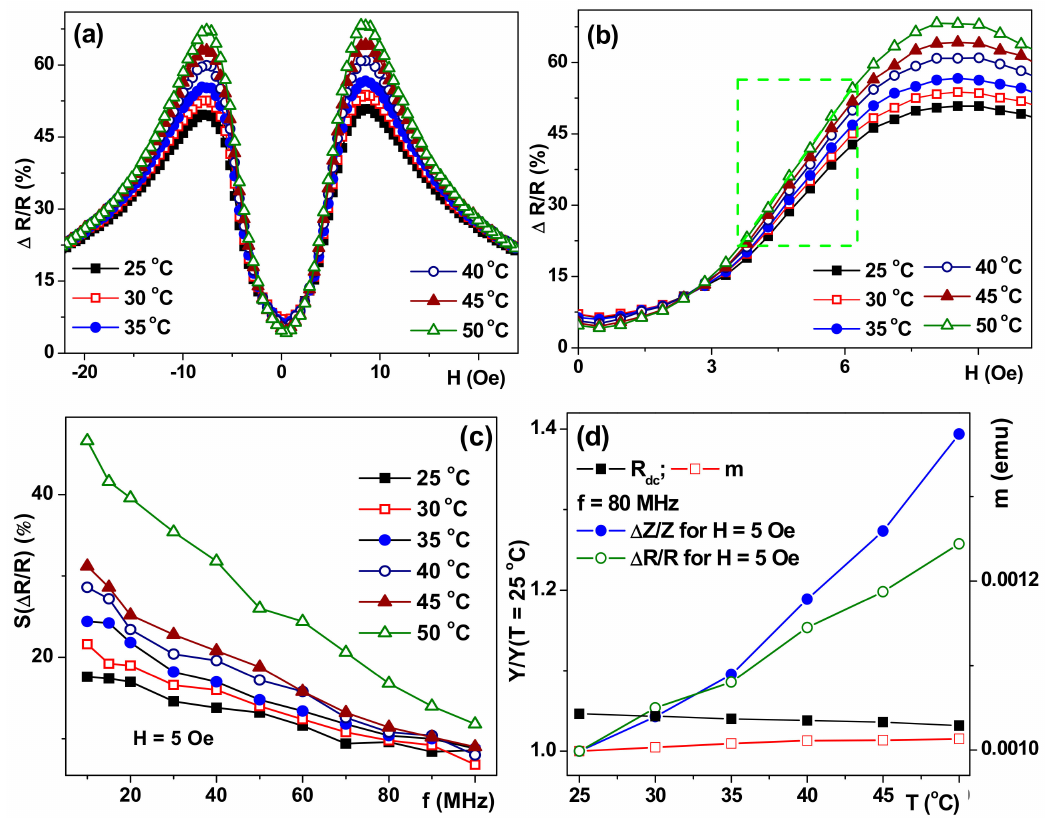
Figure 5. All data for sample S. Field dependencies of the GMI ratio for thereal part of the total impedance for at f = 80 MHz measured at different temperatures ( a ). A section of linear dependence of a ∆ R/R (working interval) is shown by the light green dashed line ( b ). Frequency dependencies of maximum sensitivity with respect to an applied field in H = 5 Oe for the ∆ R/R ratio ( c ). Temperature dependencies of Y/Y(T = 25 ◦ C) parameters, where Y = R dc , m, ∆ Z/Z, and ∆ R/R ( d